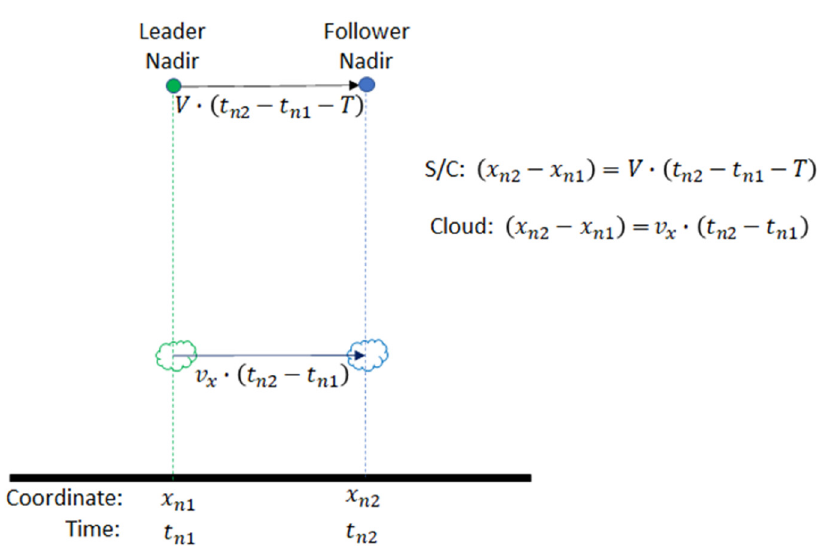
Figure 21. Leader–follower matches enable unambiguous determination of the AT winds. Consecu- tive nadir acquisitions are shown, which is the simplest